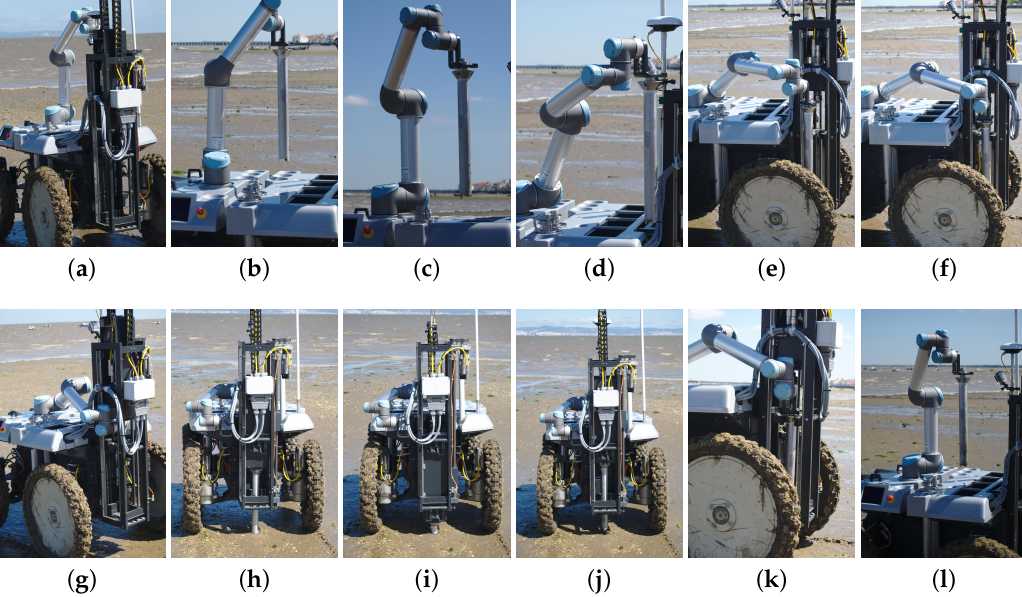
Figure 19. Snapshots of the sampling procedure. ( a )–( f ) Robot moving the sampling tube from the storage area to the drilling tool. ( g )–( j ) The robot retrieves the core using the drilling tool. ( k ) and ( l ) Robot returning the sampling tube to the storage